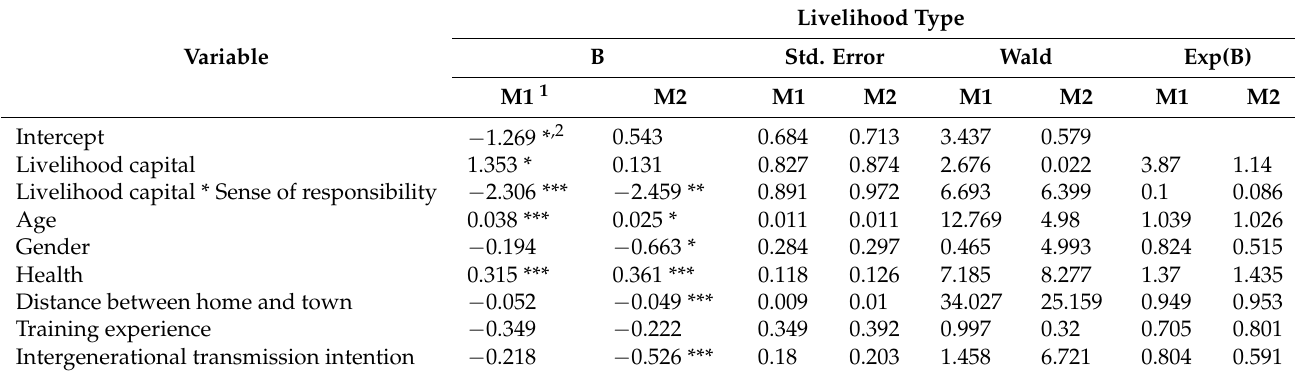
Table 8. Results of the moderating effect of sense of